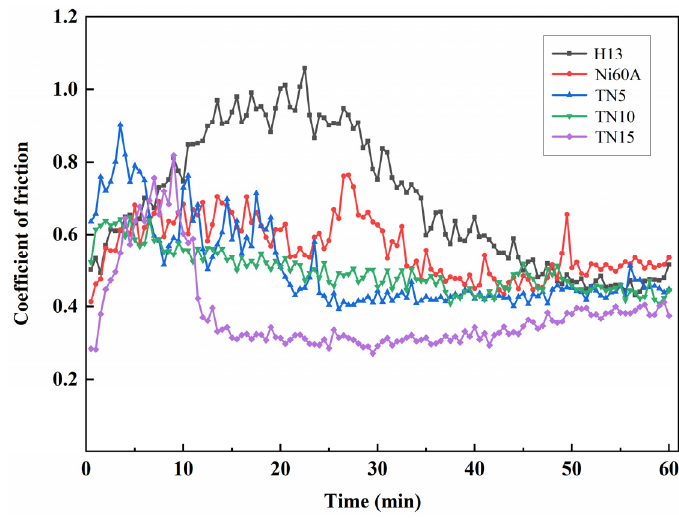
Figure 11. Friction coefficient of different specimens.